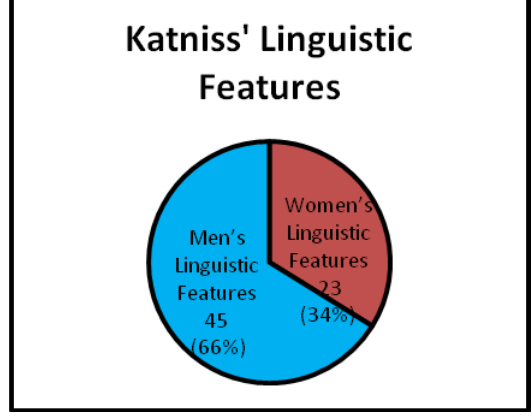
Figure 1: Katniss’ Linguistic